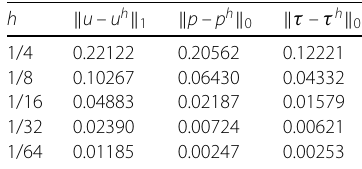
Table 1 The illustration of the error for the Oseen viscoelastic fluid flow with standard FE